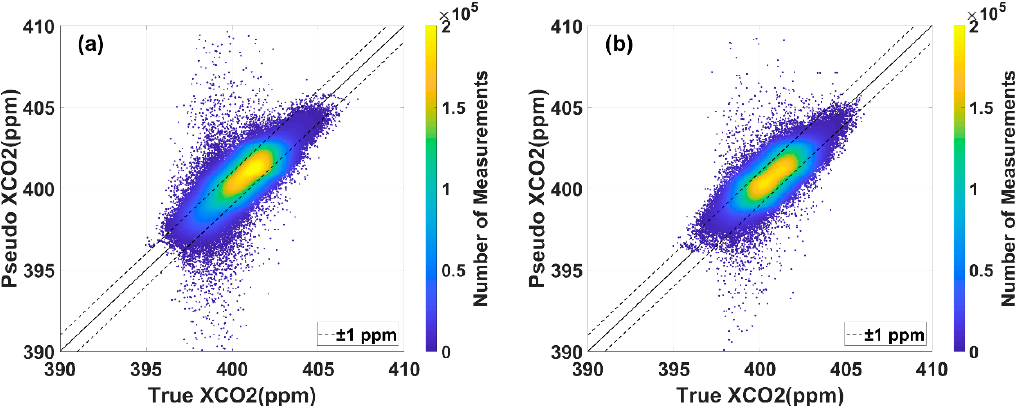
Figure 11. The comparison between AC-IPDA lidar 16-day pseudo measurements XCO 2 and model true XCO 2 ; ( a ) and ( b ) are the results of the day and night, respectively. The color in the subgraph indicates the density of the measurement points in the area of 1 × 1 ppm. The solid black line has a slope of one and stands for the ideal input and output; the dotted black line shows the deviation range of ± 1 ppm set by the ideal value.